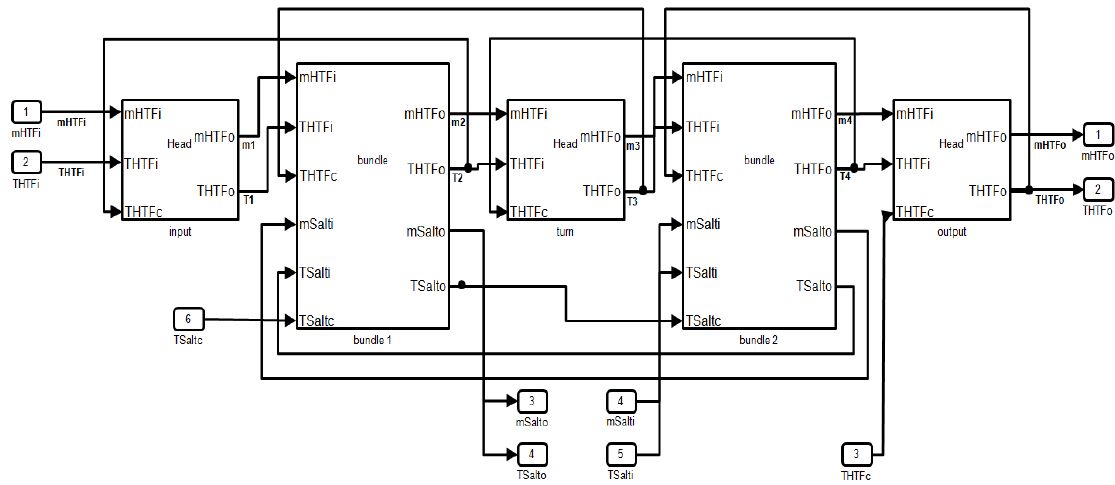
Figure 9. Diagram for the heat